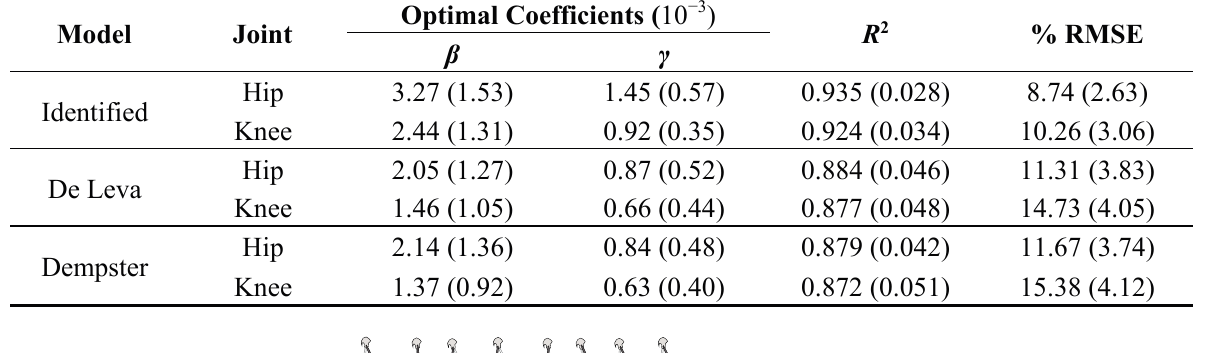
Table 7. Average values of the optimal coefficients, R 2 and normalized RMS errors for the experiment on gait training. Standard deviations are presented in parentheses.